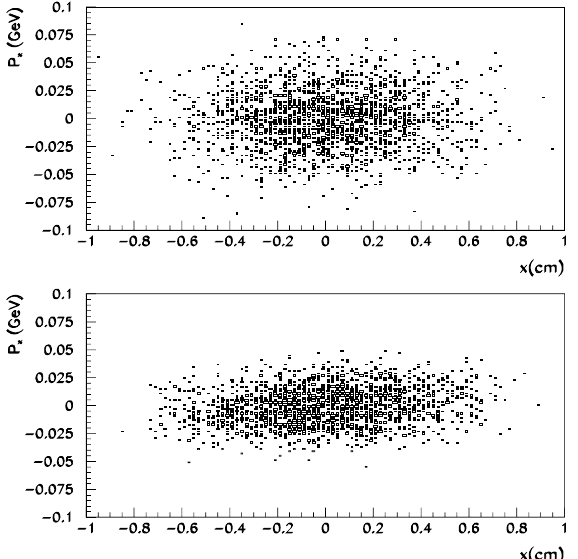
FIG. 36. x - p x phase space distribution at the beginning (top) and at the end (bottom) of the absorber described in the